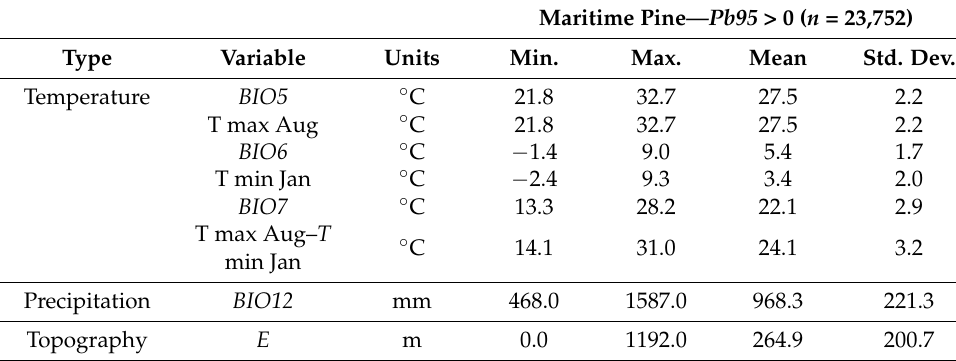
Table 4. Summary data for species presence in COS 1995 ( Pb95 > 0).